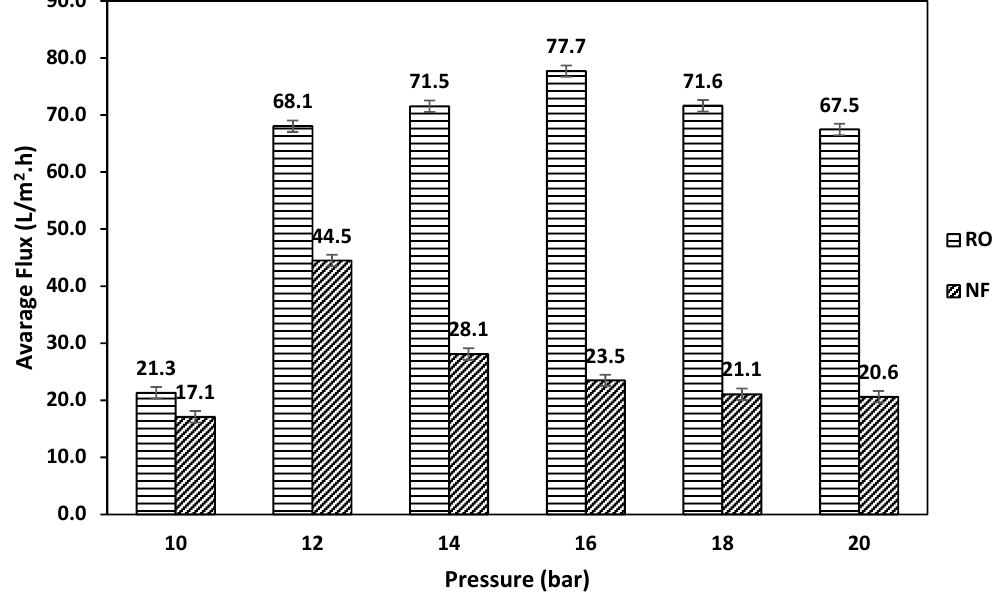
Figure 3. Average water flux of reverse osmosis (RO) and nanofiltration (NF) at different feed pressures. SEM images of unused and used RO and NF membranes at different applied pressures are shown in Figure 4b–d. The used RO membranes at an applied pressure of 12, 16 and 20 bar can be observed. It can be seen from the SEM images that as the applied pressure increased, more accumulation of foulant materials occurred on the surface of the membrane. A similar observation was detected on the nanofiltration membrane, where the amount of the accumulated foulants increased on the surface of the membrane as the feed pressure increased (Figure 4f–h). TSE is rich in organic matter that could be